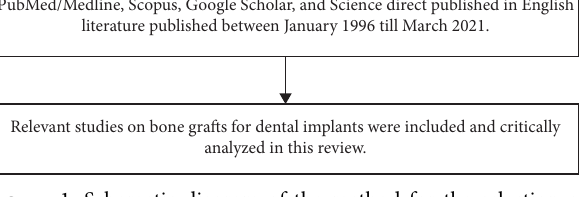
Figure 1: Schematic diagram of the method for the selection of